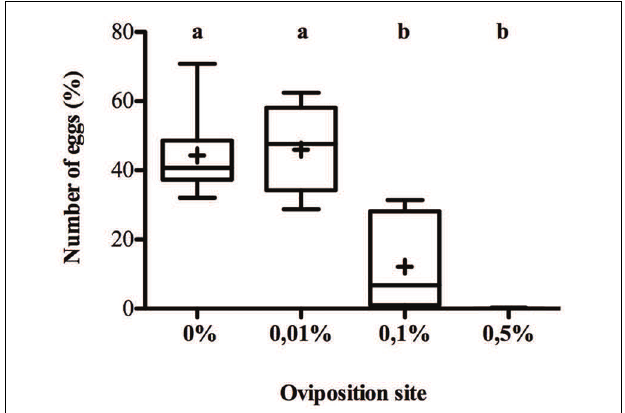
FIGURE 1 | Drosophila melanogaster oviposition preference on menthol-enriched food. Females were given a choice to lay eggs on four sites containing food enriched with 0, 0.01, 0.1, or 0.5% menthol during 12 h. Eggs were then counted for each site and the percentage of eggs in each site is given in the y -axis. Data are represented both with their mean (noted by + ) and by box-and-whisker plots (the bars represent the first and third quartiles (Q1 and Q3) with the horizontal band inside the bar indicating the median value; the whiskers indicate the minimum and maximum of all of the data. Different letters indicate a significant difference (Kruskal–Wallis, K 4 df = 54.76, p < 0.00001) ( N =